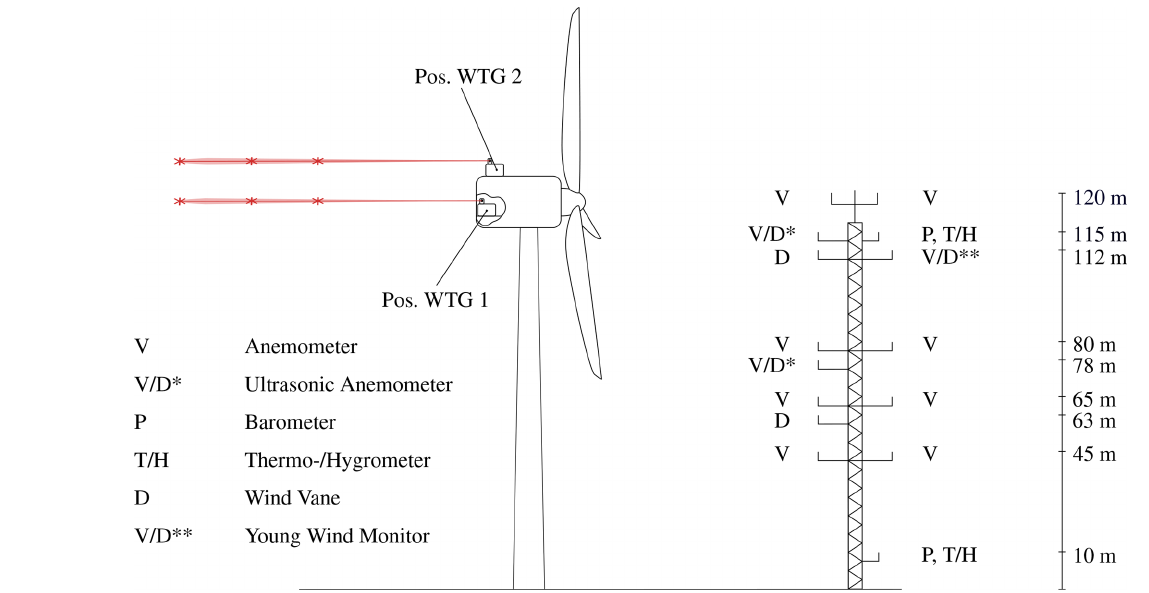
Figure 2. Met mast (MM) measurement equipment and lidar positions (Reinwardt et al., 2020).